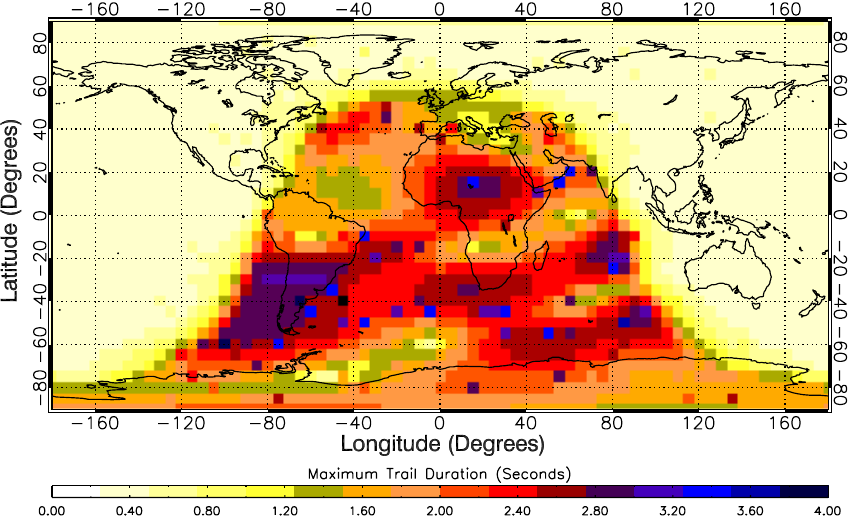
Fig. 8. A global snapshot of the meteors’ trail duration, measured in seconds, is plotted above. This simulation for a 1µg meteor traveling at 55kms − 1 with an entry angle of 45 ◦ on 27 June at 00:00UT. The units of the color bar are in seconds after meteor trail creation. The simulated meteor is identical to Fig. 2b with the exception of the date. Notice the differences in the global structure of trail duration compared to Fig. 2b, which is simulated on 1 January. The differences are caused by the changes in the atmosphere throughout the seasons; namely the structure of electron density and the magnitude of the horizontal